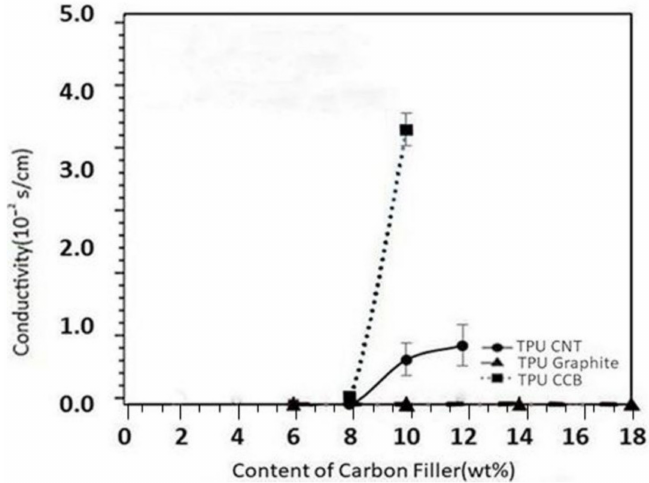
Figure 3. The conductivity of TPU / carbon composites based on the content of carbon